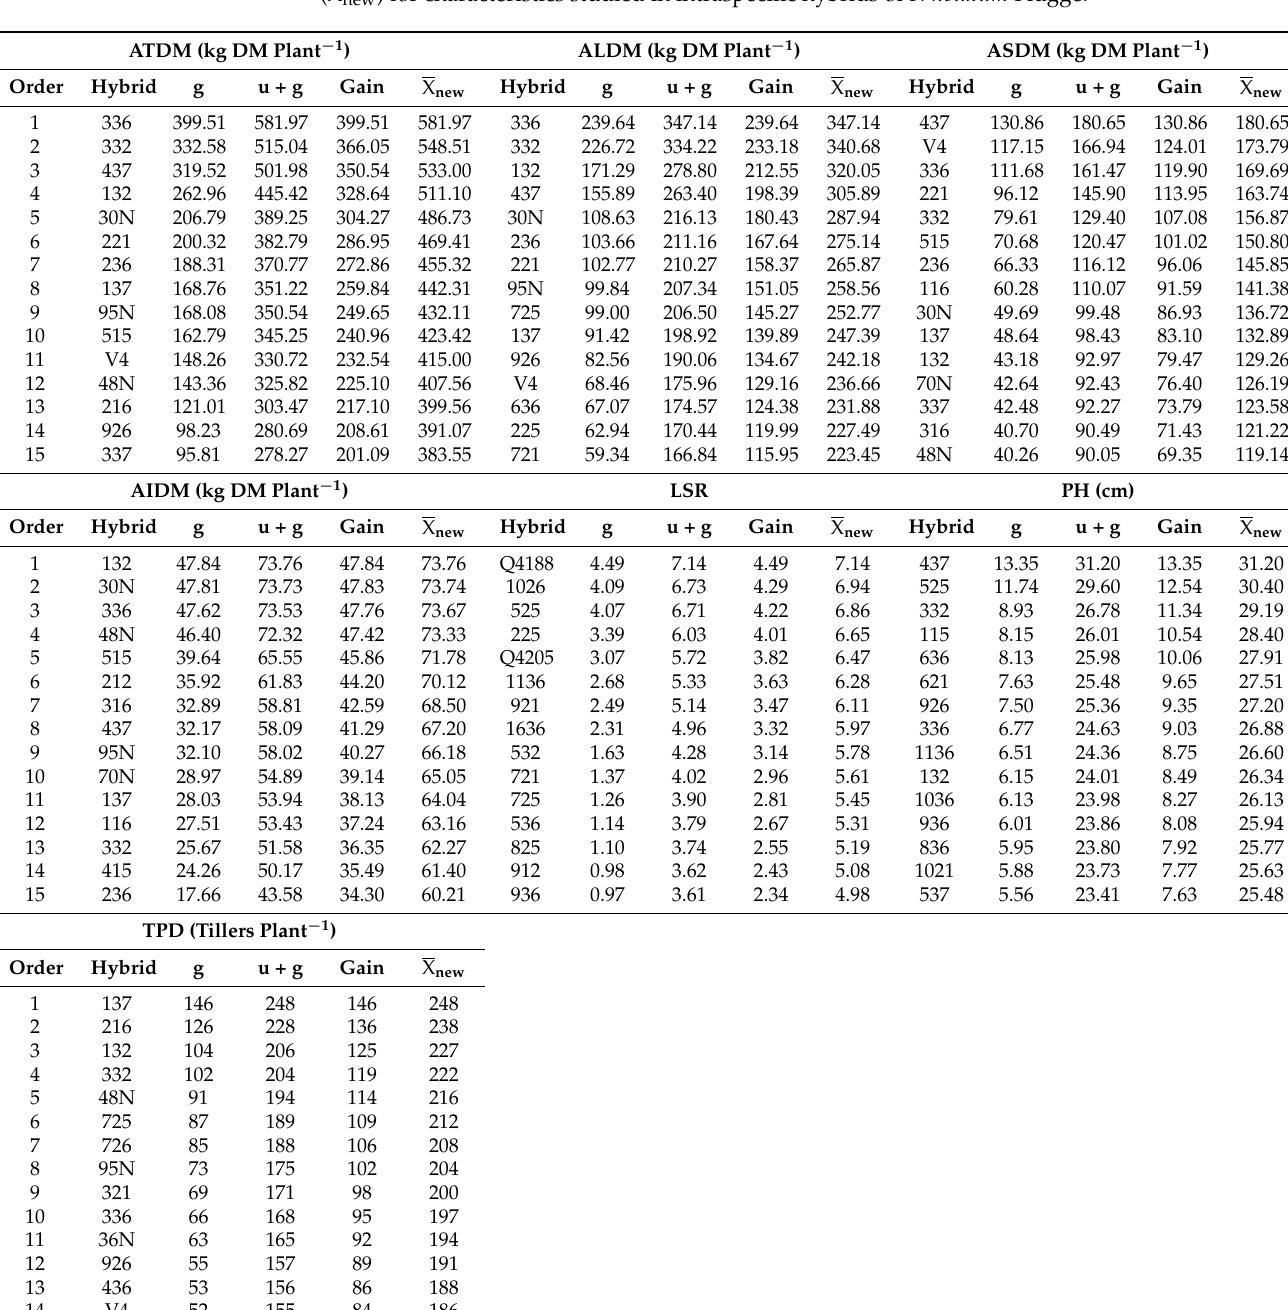
Table 3. Predicted genotypic effect (g), genotypic value (u + g), genetic gains (gain) and new average (X new ) for characteristics studied in intraspecific hybrids of P. notatum